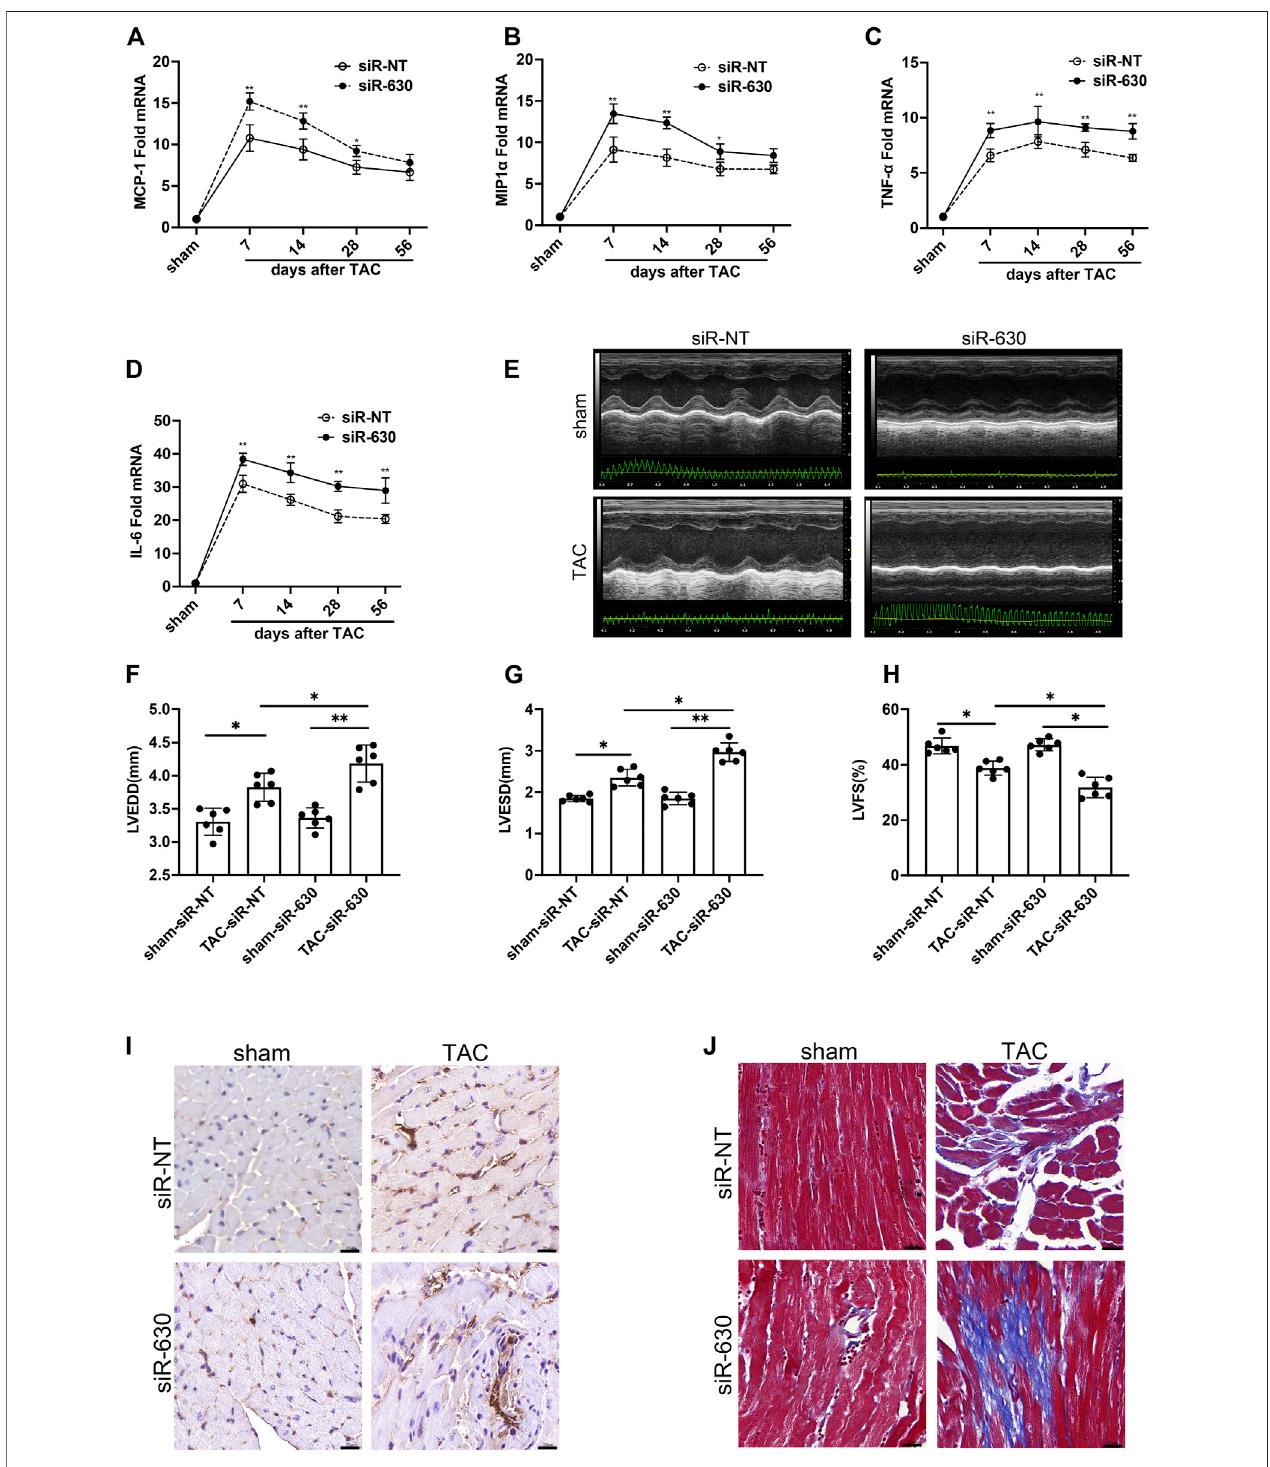
FIGURE2| EGFL7-KDisassociatedwithdeteriorationofcardiacremodelinginTAC.C57BL/6JmiceweresubjectedtoeithershamorTACoperation,then2 ′ Ome modi fi ed miRNA-630 (2 umol/L, twice a week) or siRNA-NT was intraperitoneally injected the second-day post-TAC. Echocardiograms and morphology changes were observed 4 weeks after TAC ( n = 6 in each group). (A) expression and quantitative analysis of in fl ammatory cytokines mRNA of MCP-1 and MIP1 α (B) , TNF- α (C) , IL-6 (D) (* p < 0.05, ** p < 0.01 vs. relative siRNA-NT by two-way ANOVA followed by Bonferroni ’ s test). (EFGH) representative images of echocardiograms and quantitative analysis of left ventricular end-diastolic diameter (LVEDD), left ventricle end-systolic diameter (LVESD), left ventricle fractional shortening (LVFS) between different groups (* p < 0.05, ** p < 0.01 by one-way ANOVA followed by Tukey ’ s test). (I) Representative immunohistochemical staining of CD68 indicated in fi ltration of macrophages. scale bar = 20 μ m. (J) Representative Masson staining indicated interstitial fi brosis was increased in siRNA-630-TAC. Scale bar = 20 μ m. All data represent the mean ± SD from at least 4 independent experiments. Frontiers in Pharmacology |